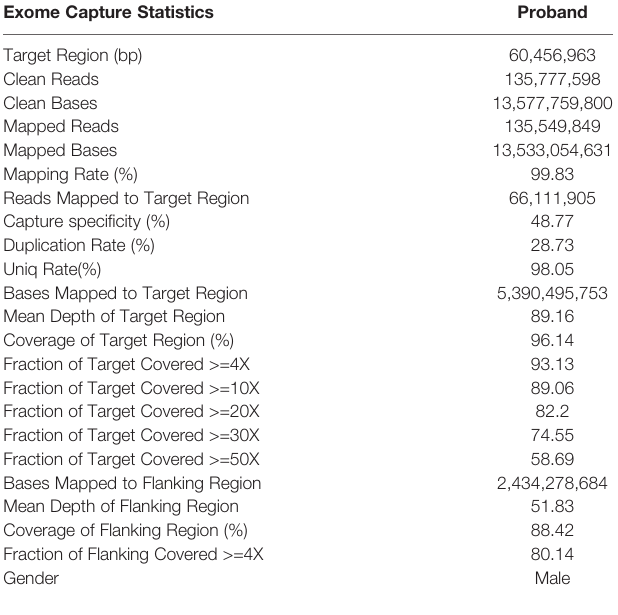
TABLE 2 | Details of whole exome sequencing (WES).